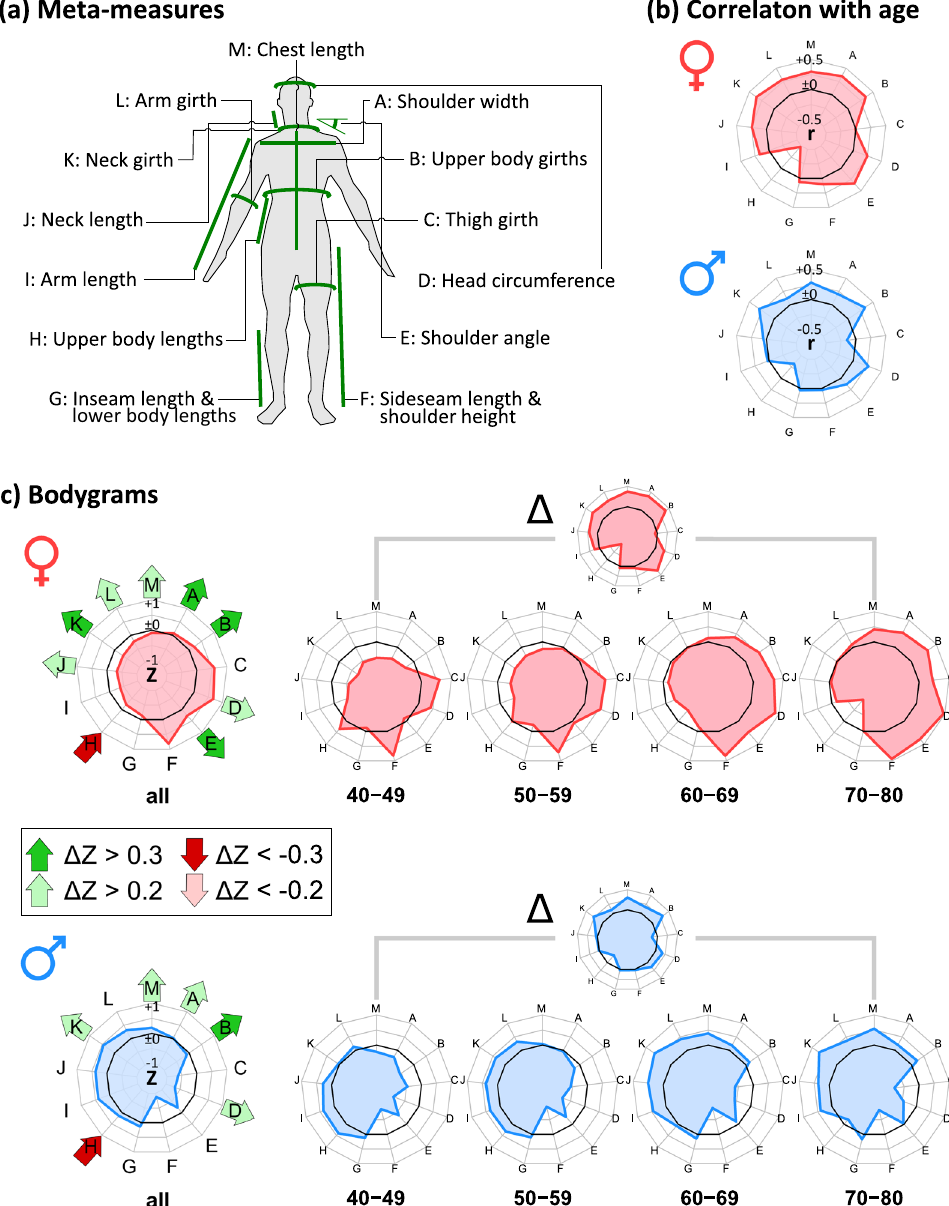
Fig. 2 Alterations of body measures with age. a Assignment of the 13 meta-measures de fi ned previously. b Correlation of the meta- measures with age visualized as polar diagram. The black polygon refers to r = 0. c The “ bodygram ” visualizes the meta-measures in Z -units as a polar diagram. The black polygon refers to Z = 0. Mean bodygrams of male and female participants averaged over all ages (left part) and after strati fi cation into age decades (right part) reveal gender-speci fi c differences and age-dependent changes of the meta-measures. Difference Δ -bodygrams visualize the changes of the meta-measures between the 40 – 49 and 70 – 80 years intervals. The green and red arrows in the left part highlight the most pronounced differences ( Δ Z